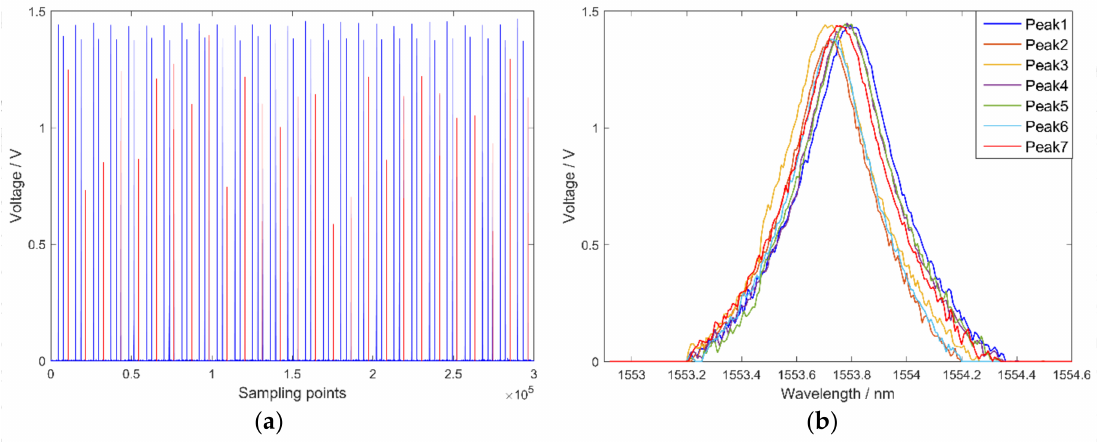
Figure 5. The waveforms of the FBG sensor: ( a ) original reflection spectrum of the FBG sensor; and ( b ) comparison of the FBG sensor’s seven actual